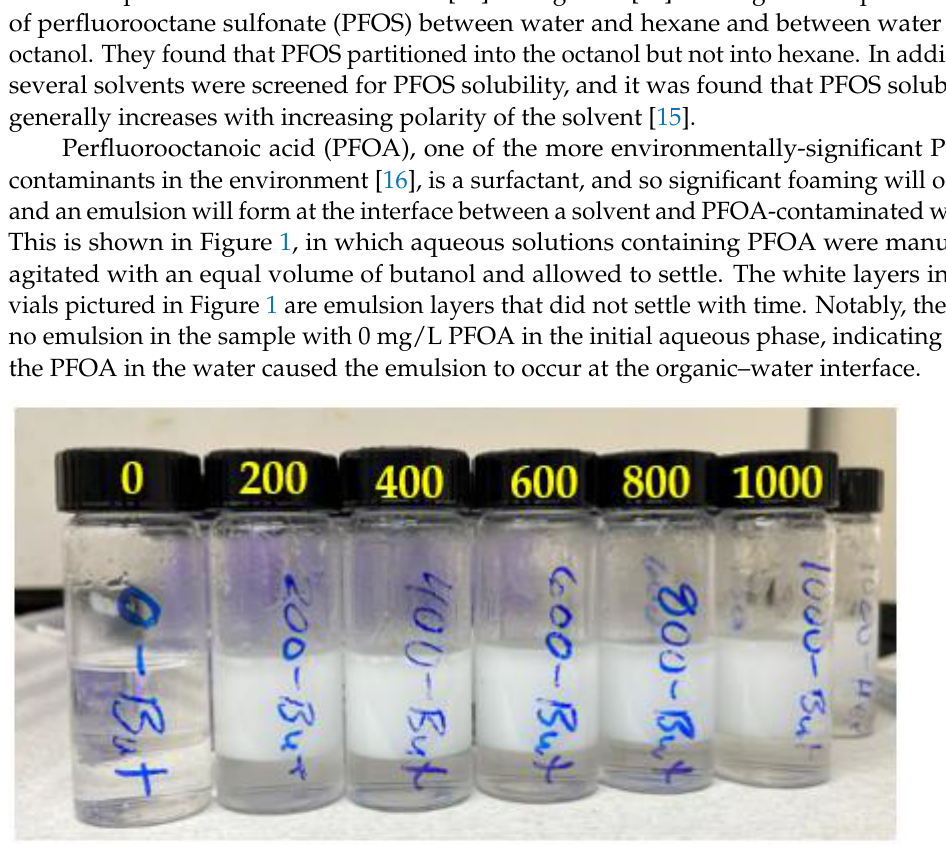
Figure 1. Aqueous PFOA solutions in deionized water with equal volumes of 1-butanol. The numbers on the vials indicate the concentrations of PFOA in the initial aqueous solution (0 mg/L to 1000 mg/L in 200 mg/L increments).